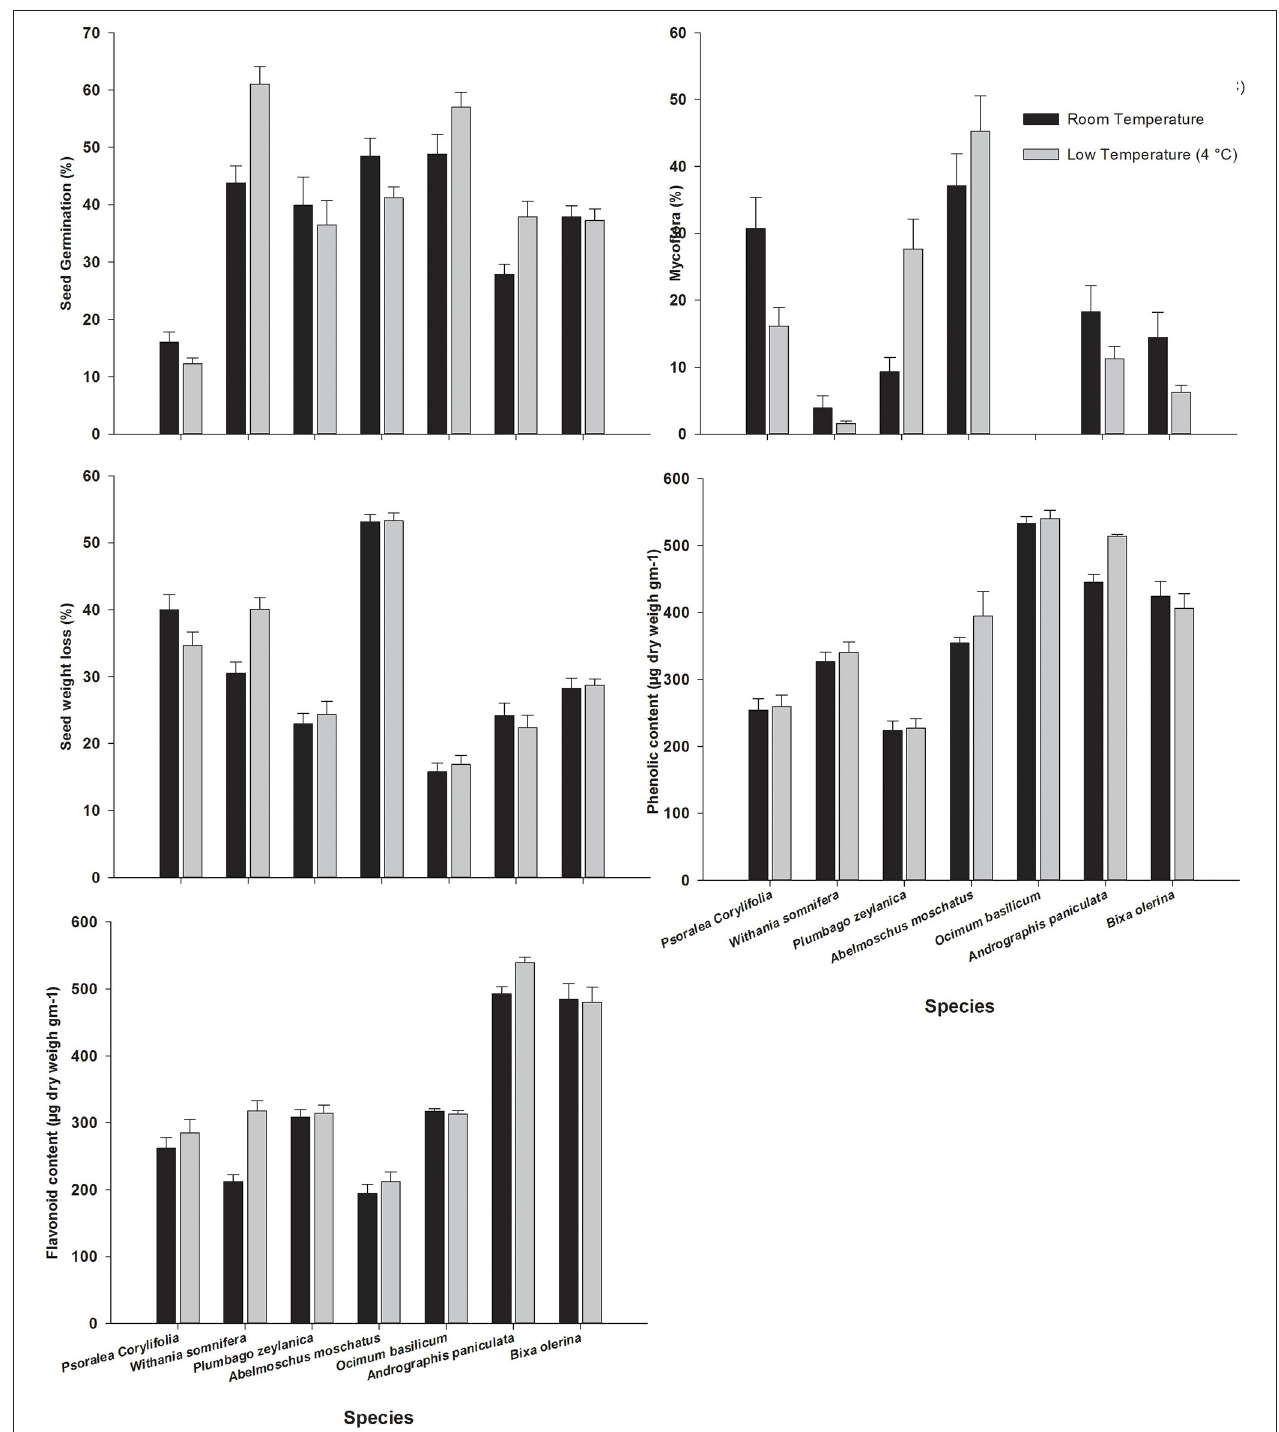
FIGURE 3 | Influence of temperature gradients during seed storage on seed germination (%), seed weight loss (%), mycoflora (%), phenolic content ( µ g dry weight gm − 1 ), flavonoid content ( µ g dry weight gm − 1 ) in the seven commercially important medicinal plants. Bars with different letters are significantly different according to the Tukey’s test ( P <